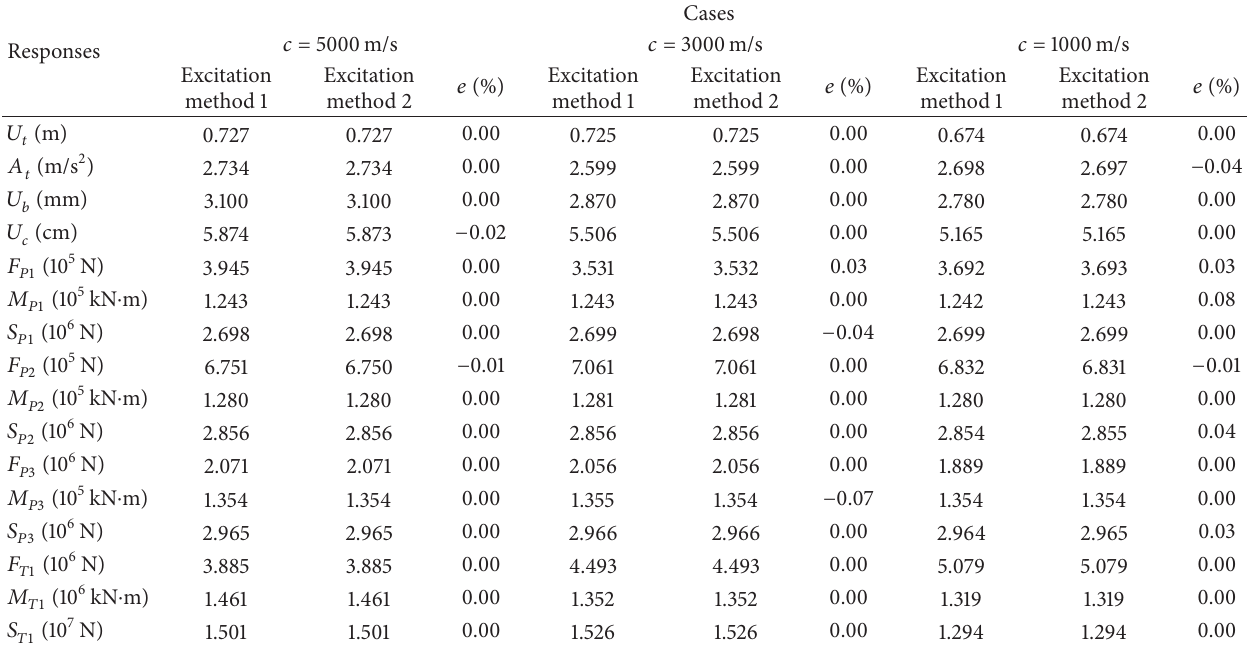
Table 7: Comparisons of the structural peak seismic responses under different excitation methods under the excitation of 𝑏 1 .